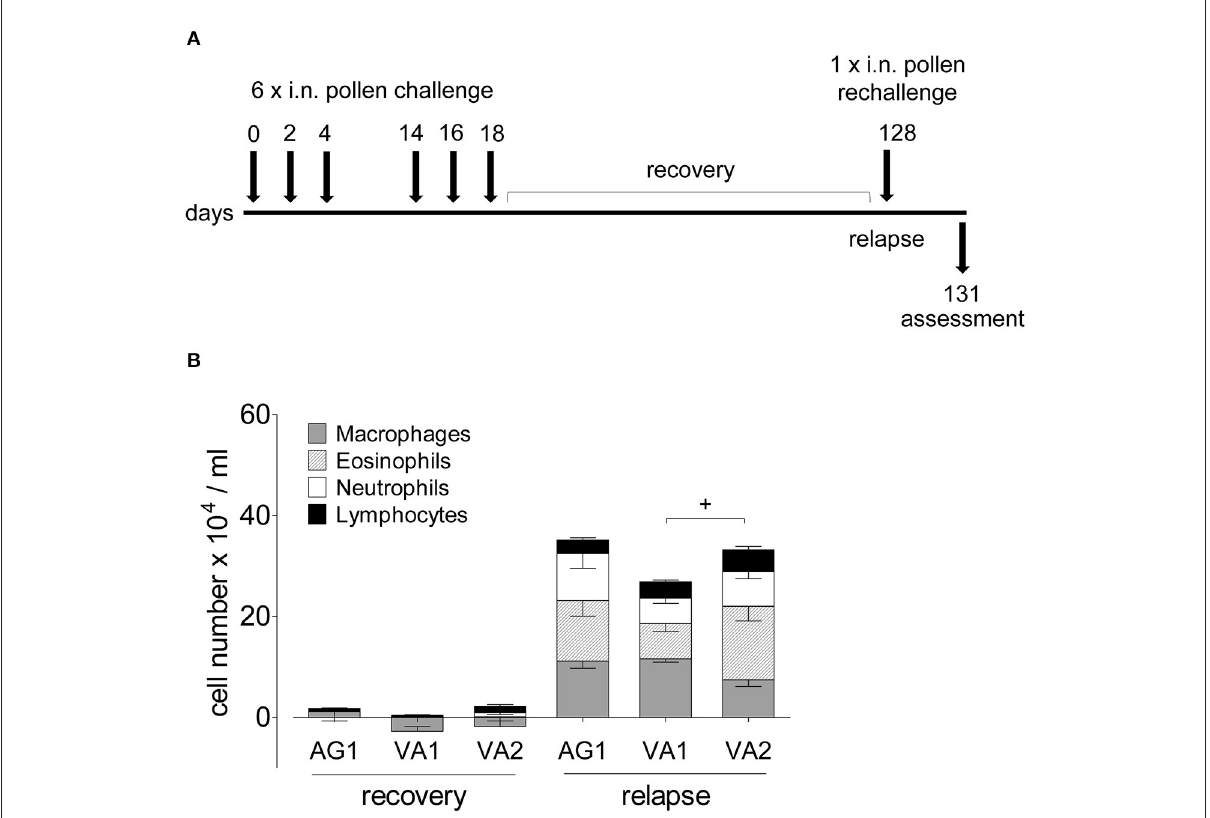
FIGURE6 Airway inflammation during disease relapse elicited by AG1, VA1 and VA2 pollen. (A) Protocol scheme of disease relapse which illustrates the induction of acute disease with the administration of six RWP doses over 21 days, a recovery period of at least 90 days, followed by a challenge with a single 10 ug intranasal RWP dose before evaluating the mice at 72h. (B) Total and differential BAL cell counts of mice recovered from AG1, VA1, or VA2 pollen-induced disease and at relapse. Data are presented as mean ± SEM minus PBS control and are representative of at least two experiments; n = 4–8 . Significant difference in eosinophils: + p < 0.05 , t